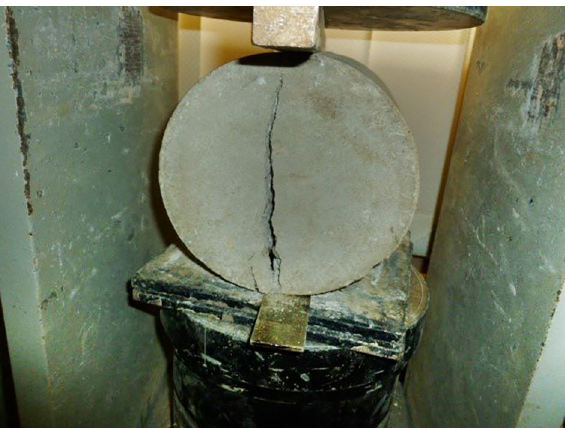
Fig. 2. Failure of cylindrical sample